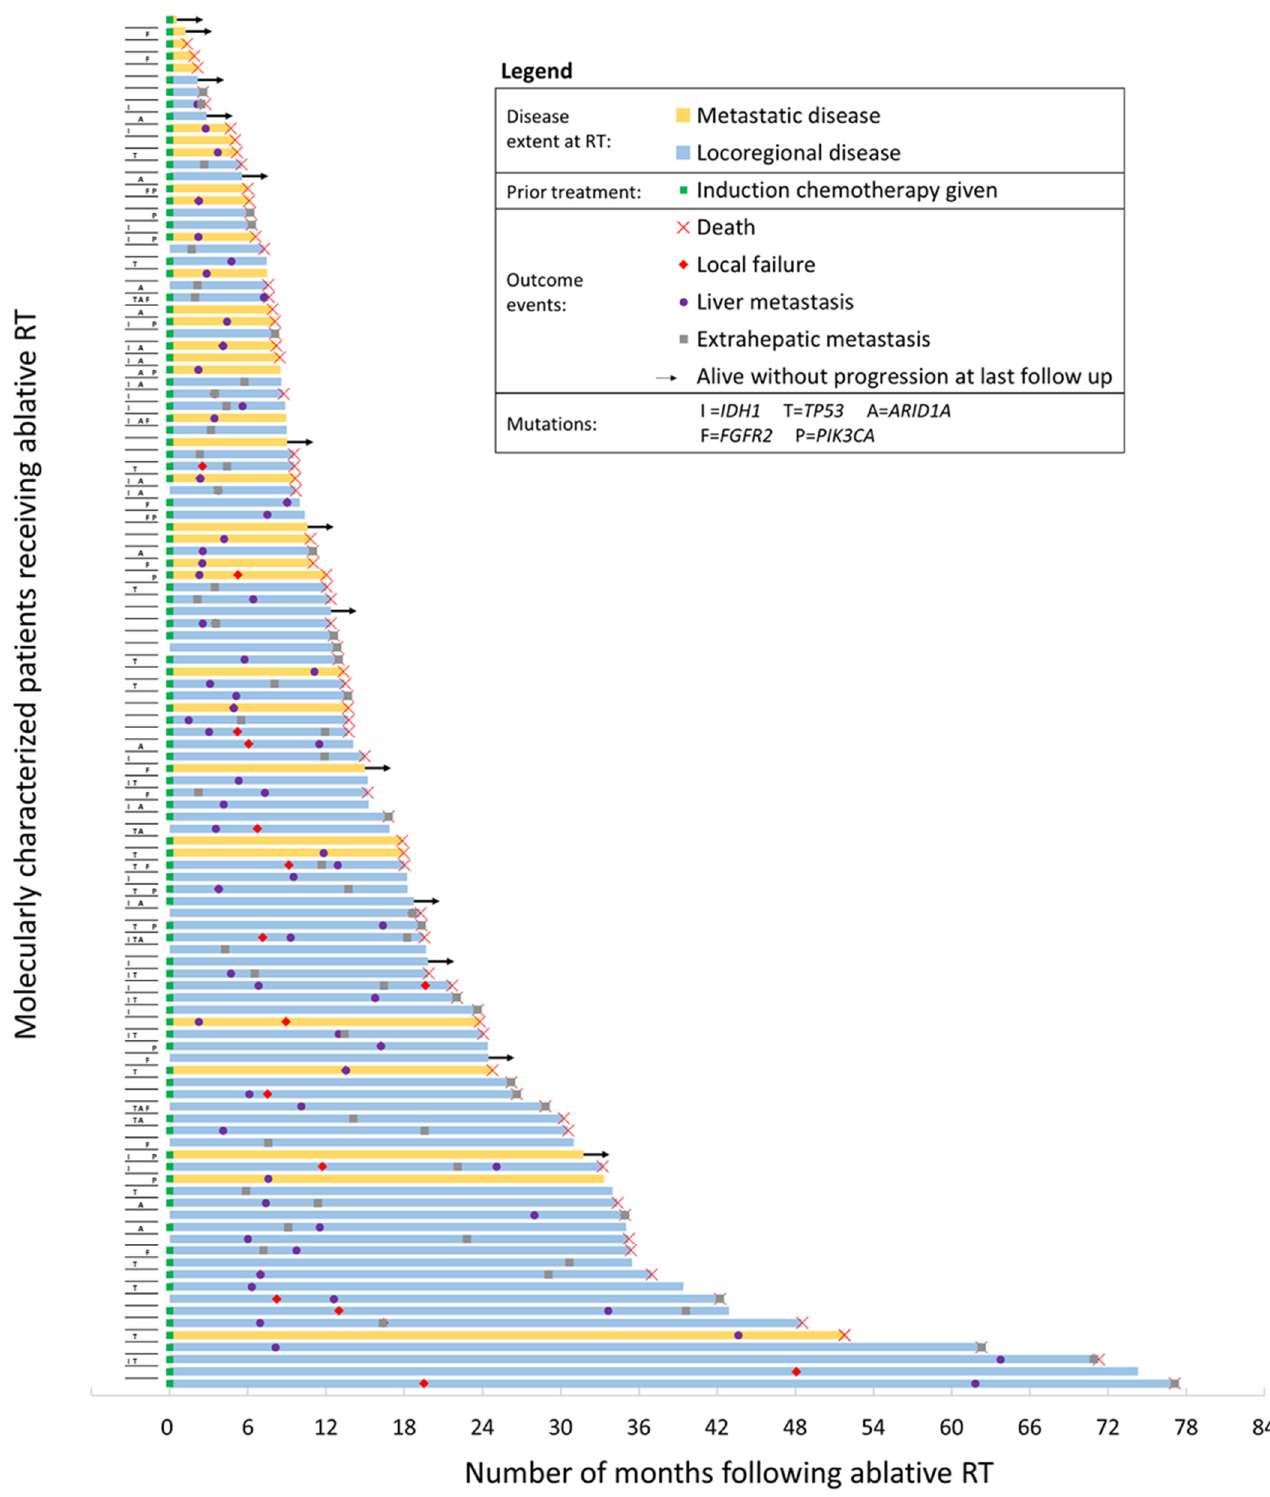
Figure 2. Patient-level outcomes for 114 patients receiving ablative radiotherapy for treatment of intrahepatic cholangiocarcinoma. The latency between radiotherapy and outcome, either last follow-up or death, is represented by the length of each bar shown. Mutation statuses for common mutations are provided.